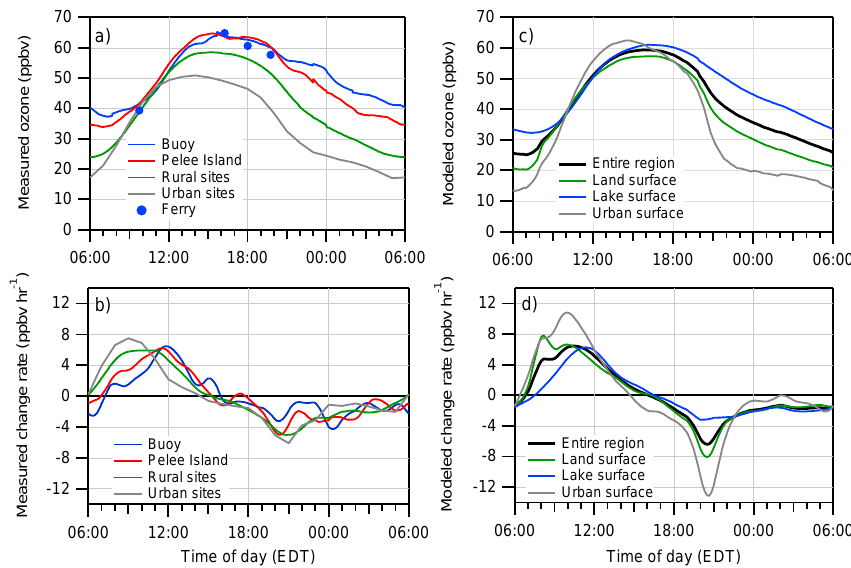
Fig. 2. (a) 2-h running averages of surface ozone for the Buoy, Pelee Island, rural-site composite, urban-site composite, and the average of ferry measurements for trips scheduled on all weekdays; (b) running change rate between two consecutive hours of the measured data; (c) AURAMS diurnal averages at surface level over the 2.5-km grid sub-domain in Fig. 1 grouped by lakes, land and urban areas; (d) running change rates between two consecutive hours of the model